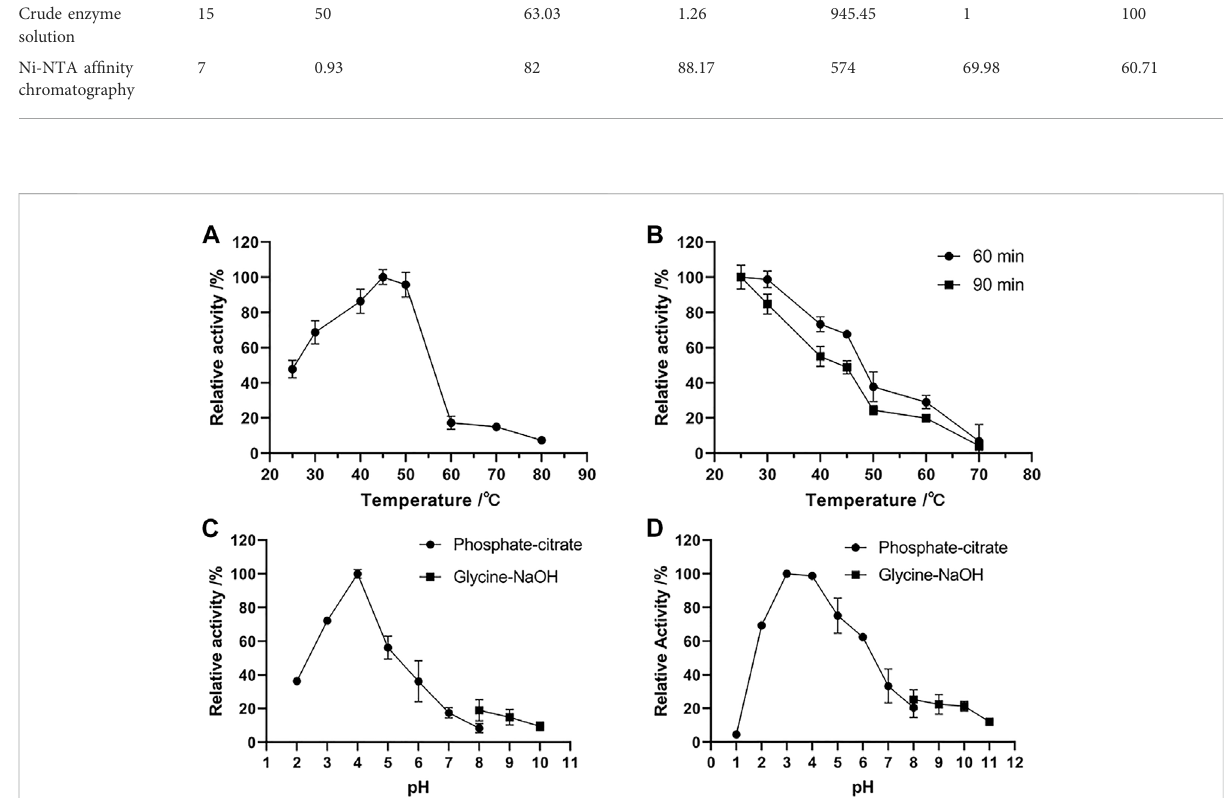
FIGURE 3 Effects of temperature and pH on the activity and stability of chitinase Δ 30 Af ChiJ. (A) The optimum temperature of Δ 30 Af ChiJ. The activity of Δ 30 Af ChiJ was measured at pH 7.0 with colloidal chitin as the substrate. The highest activity of Δ 30 Af ChiJ at 45 ° C was de fi ned as 100%. (B) Thermostabilityof Δ 30 Af ChiJ.ThethermostabilitywasmeasuredatpH4.0.Thehighestenzymeactivityafterpreincubationwasde fi nedas100%. (C) The optimum pHof Δ 30 Af ChiJ.The activity of Δ 30 Af ChiJ was measured at 45 ° C with colloidal chitin as the substrate. The activity of Δ 30 Af ChiJ atpH4.0wasde fi nedas100%. (D) pHstability of Δ 30 Af ChiJ.Stabilityof Δ 30 Af ChiJafterincubationatdifferentpHat30 ° Cfor 3 hwithout substrates. The activity of the enzyme after incubation at pH 3.0 was de fi ned as 100%. Each data point represents the mean of three independent experiments, standard errors are shown (mean ±